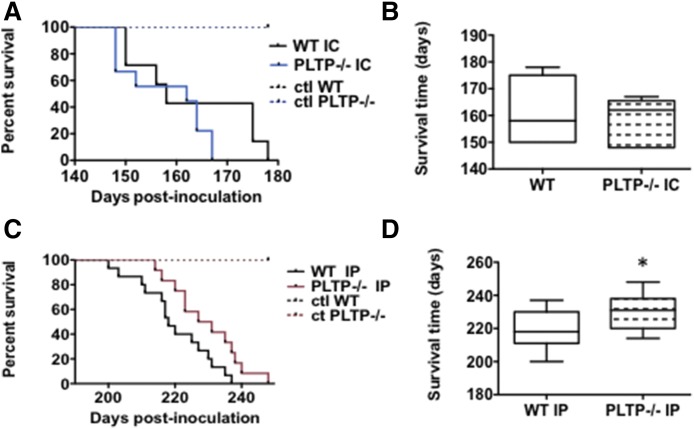
PLTP−/− mice challenged intraperitoneally with prions exhibited prolonged survival compared with WT counterparts. A: Kaplan-Meier survival plots of WT (in black, n = 10) and PLTP−/− (in blue, n = 9) mice inoculated intracerebrally with 5 μl of brain homogenate infected with 22L prion strain. In each group (WT and PLTP−/−), five mice were inoculated with 5 μl of PBS by ic (IC) route to serve as controls (ctl). B: Box-and-whiskers representation of median survival time of plots presented in (A). The median survival time, 158 dpi for WT mice versus 162 dpi for PLTP−/− mice, is not statistically different [Log-rank (Mantel-Cox) test]. C: Kaplan-Meier survival plots of WT (in black, n = 15) and PLTP−/−(in red, n = 13) mice inoculated intraperitoneally with 150 μl of brain homogenate infected with 22L prion strain. In each group, five mice were inoculated with 150 μl of PBS by the ip route to serve as controls. D: Box-and-whiskers representation of median survival time of plots presented in (C). The median survival time, 218 dpi for WT mice versus 231 dpi for PLTP−/− mice, is statistically different [*P < 0.05, Log-rank (Mantel-Cox) test].